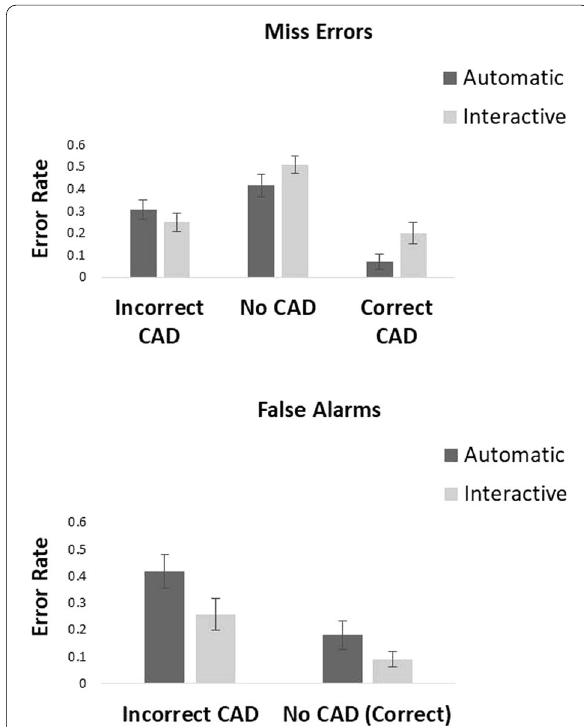
Fig. 2 Proportion of miss errors and false alarms in the automatic and interactive conditions of Experiment 1